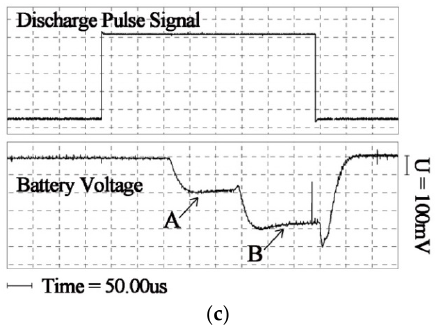
Figure 2. ( a ) Internal resistance testing equipment; ( b ) experimental setup; ( c ) pulse discharge oscilloscope schematic.